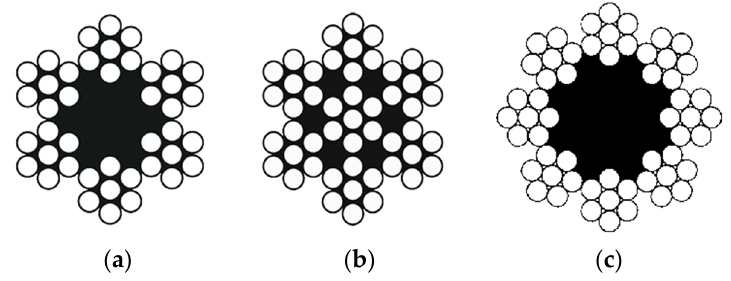
Figure 2. ( a ) 6 × 7 fiber core wire rope; ( b ) 7 × 7 wire rope; ( c ) 8 × 7 fiber core wire rope.